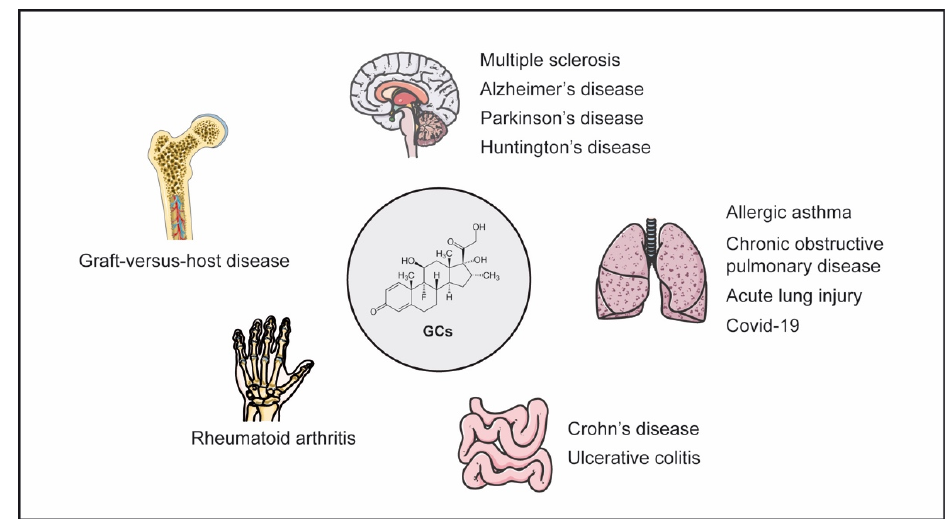
Figure 2. GC therapy of major inflammatory diseases. GCs are used to treat a multitude of organ- specific diseases affecting the brain or different peripheral tissues like the intestinal tract, lung or joints, but also systemic disorders such as graft-versus-host disease.